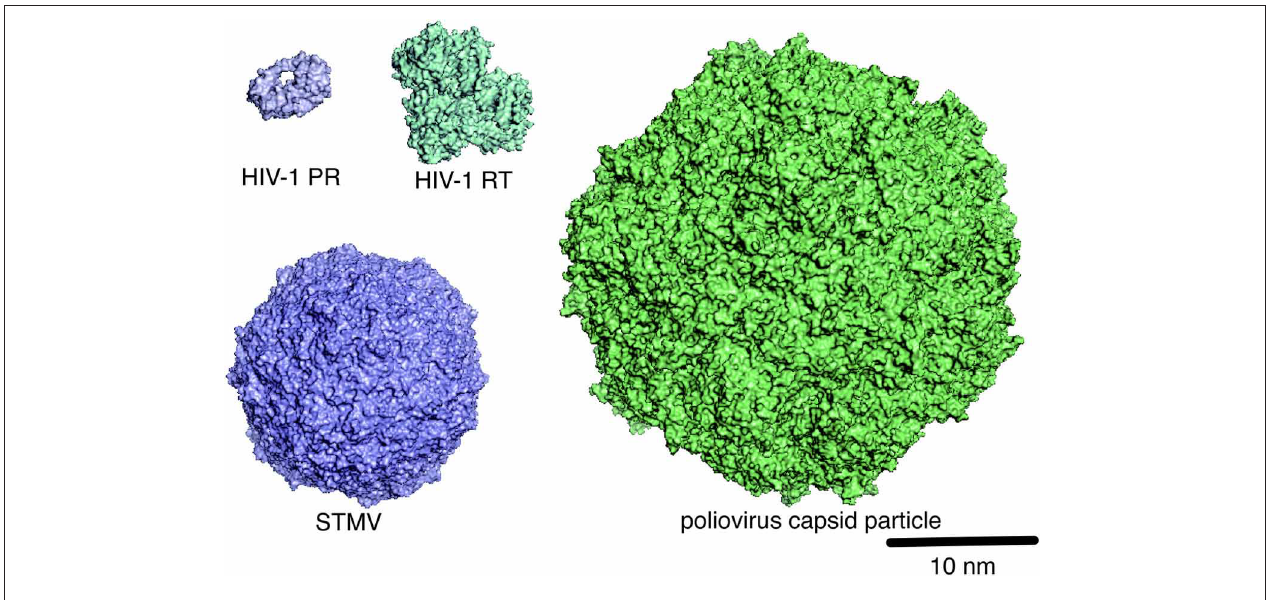
FIGURE 3 | Molecular scales of viral proteins and capsid particles. The structures of HIV-1 PR (PDB code: 1HHP), HIV-1 RT (PDB code: 1RTD), STMV (PDB code: 1A34), and poliovirus capsid particle (PDB code: 1HXS),